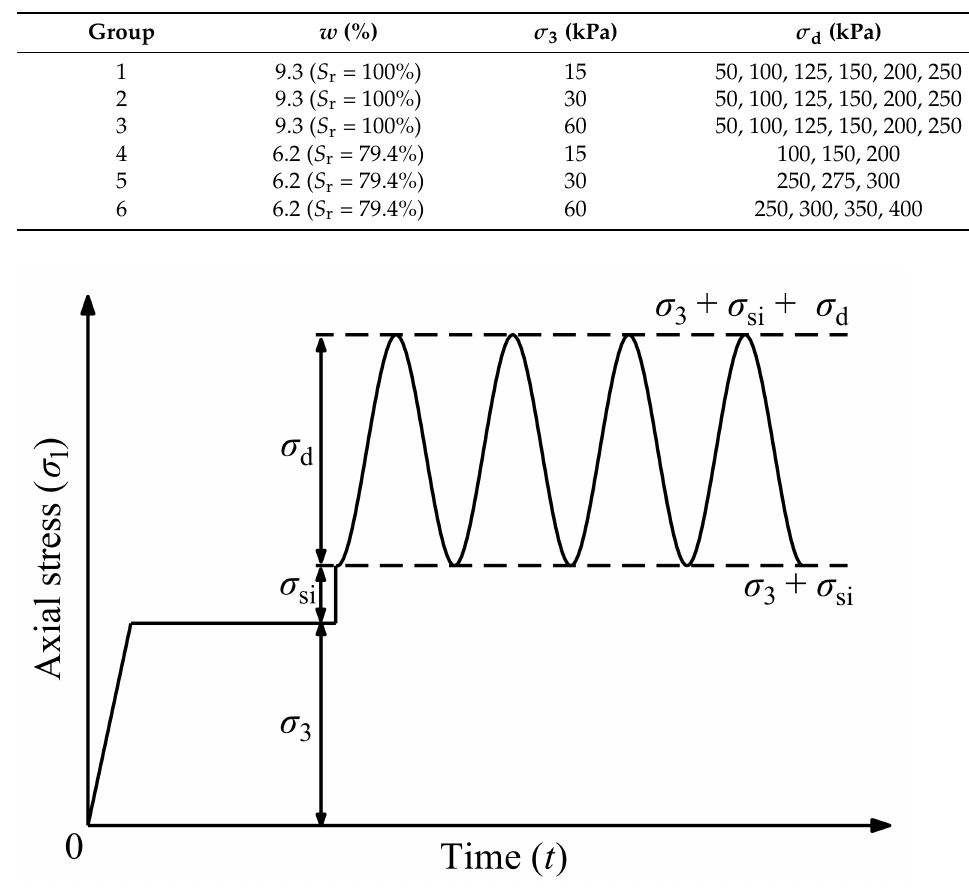
Figure 4. Cyclic loading curve